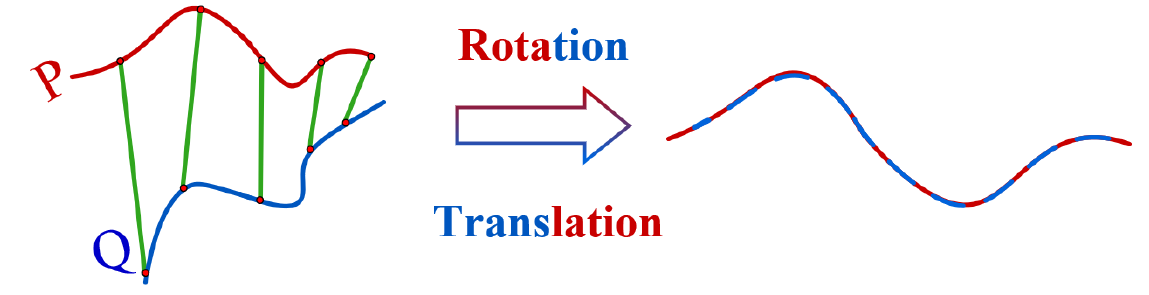
Figure 2. Principle of ICP algorithm.